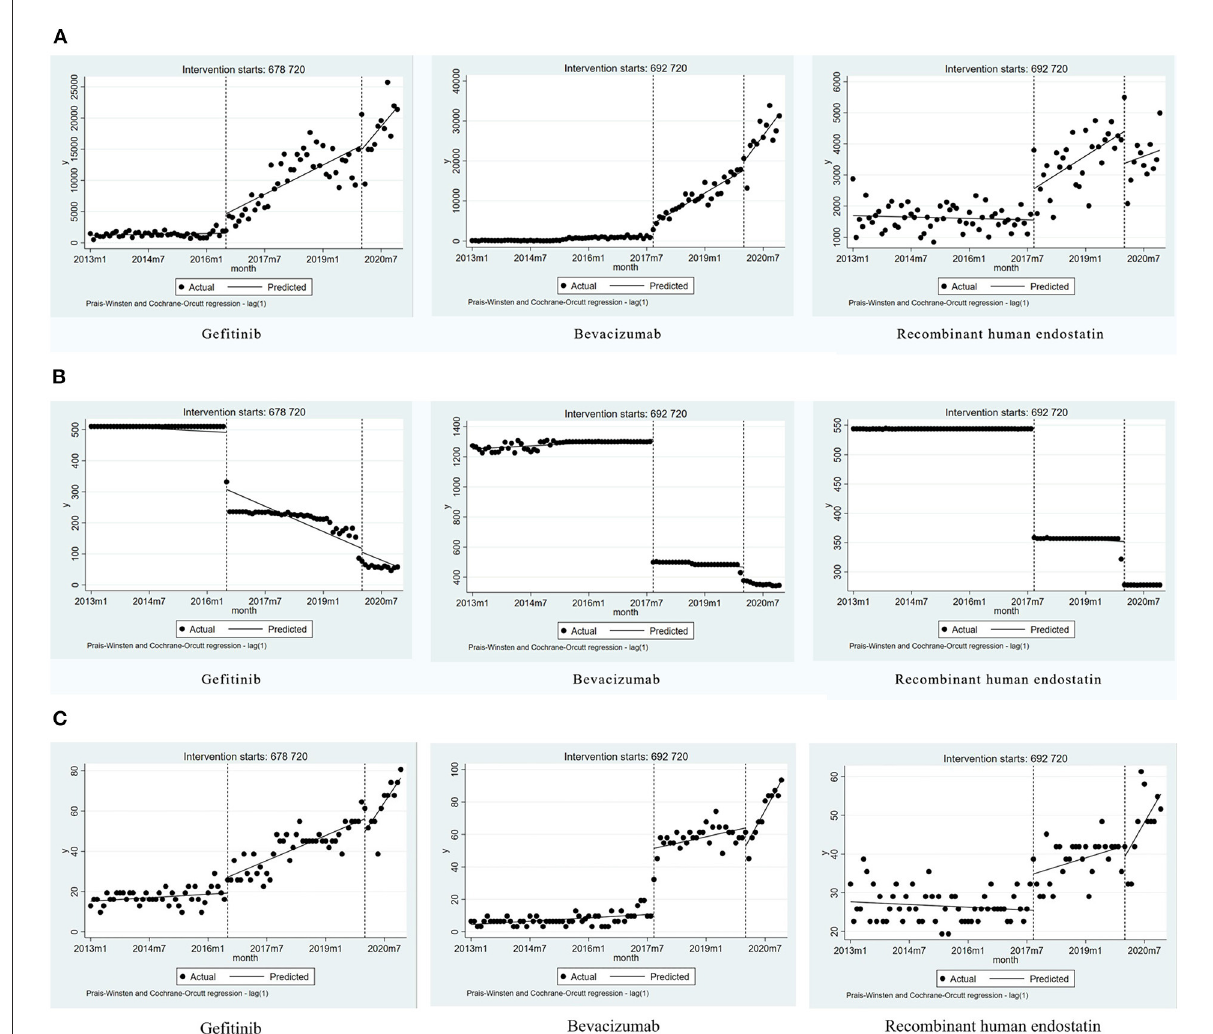
FIGURE2 Results of the regression analysis of the monthly DDDs, the monthly DDDc, and the availability of study drugs before and after policy implementation. (A) The monthly DDDs of gefitinib, bevacizumab, and recombinant human endostatin. (B) The monthly DDDc of gefitinib, bevacizumab, and recombinant human endostatin. (C) The availability of gefitinib, bevacizumab, and recombinant human